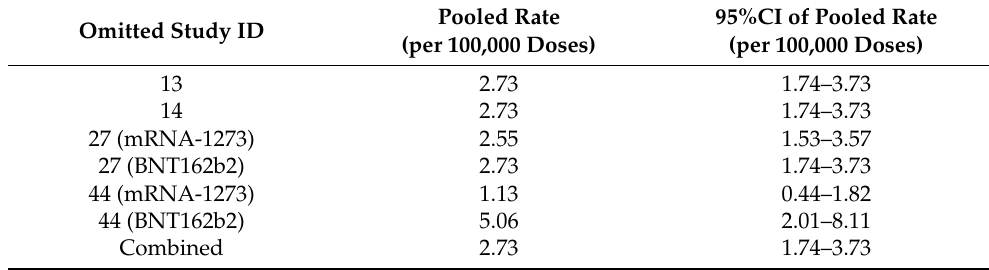
Table A5. Sensitivity analysis of anaphylaxis of mRNA vaccines of surveillance